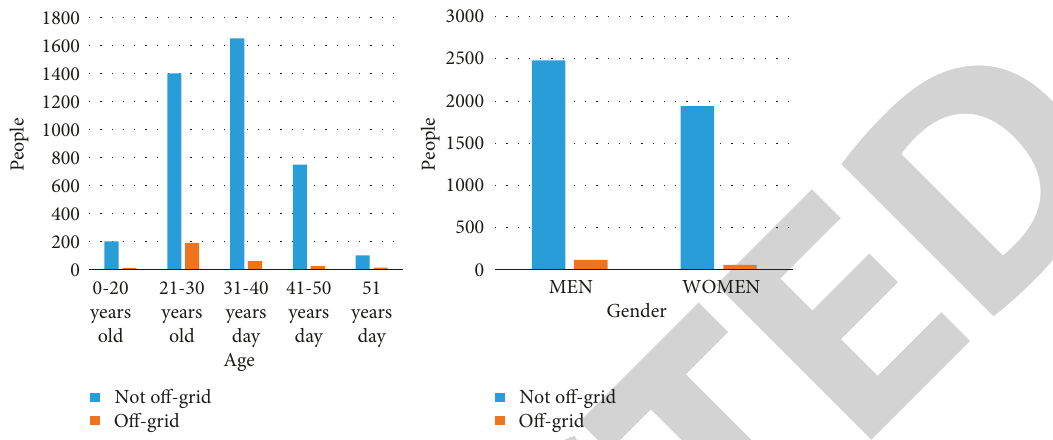
Figure 11: Statistical customer churn distribution based on age and